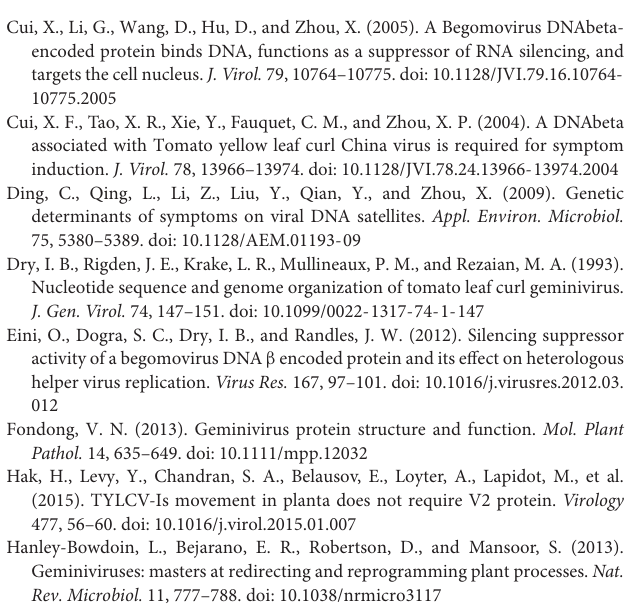
Supplementary Figure 1 | Schematic strategy for croton yellow vein mosaic virus (CYVMV) V1 and V2 gene-knockout construct development. *Marked enzymes in multiple cloning sites (MCS) are also present in the virus genome portion so cannot be used for